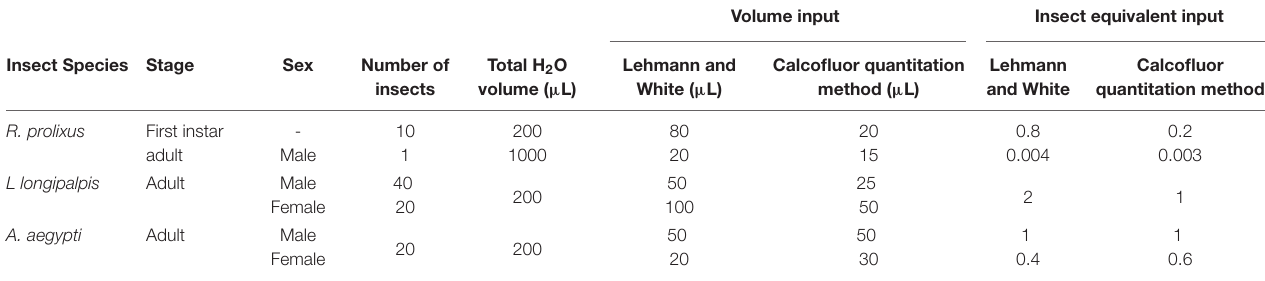
TABLE 1 | Detailed methodology for the three insect species, Rhodnius prolixus , Lutzomyia longipalpis , and Aedes aegypti .